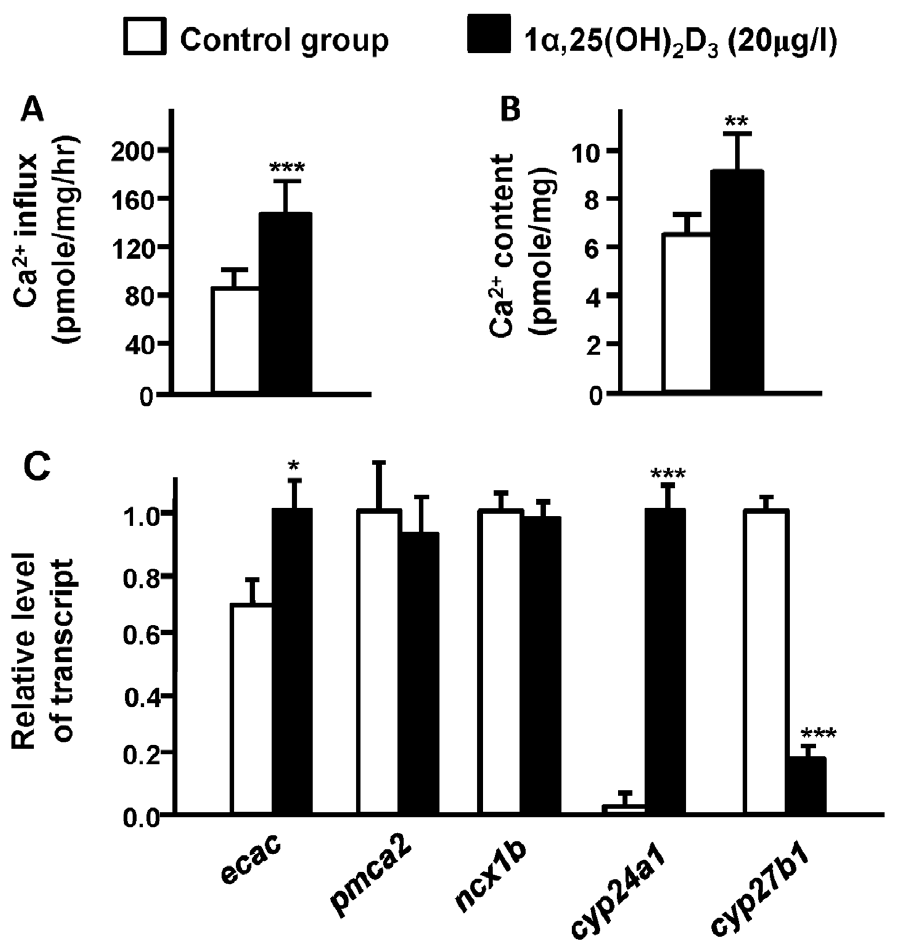
Figure 2. Effects of exogenous 1 a ,25(OH) 2 D 3 (20 m g/l) in 3-d post-fertilization (dpf) zebrafish embryos. Ca 2 + influx (A) , Ca 2 + content (B), mRNA expressions in 3-dpf zebrafish embryos (C). mRNA expressions were analyzed by a qPCR, and values were normalized to b -actin. Values are the mean 6 SD ( n =7 , 10). Student’s t-test , * p , 0.05; ** p , 0.01, *** p , 0.001.